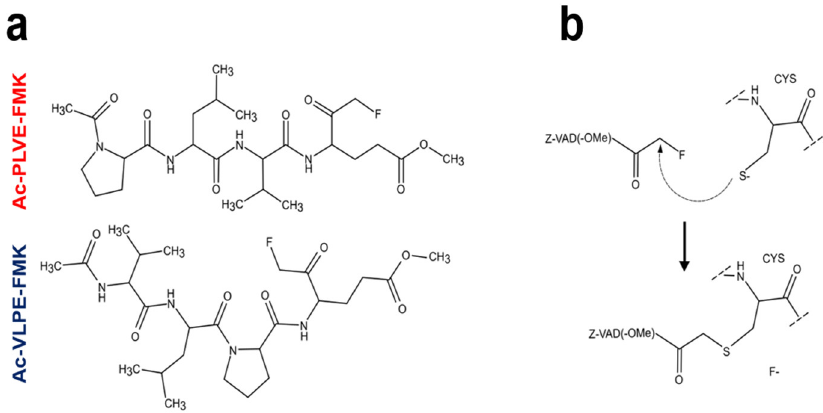
Figure 1. The structure and working mechanism of Ac-PLVE- fluoromethyl ketone (FMK) and Ac-VLPE-FMK inhibitors: ( a ) Inhibitory peptides structure and ( b ) their working mechanism based on Z-VAD-FMK